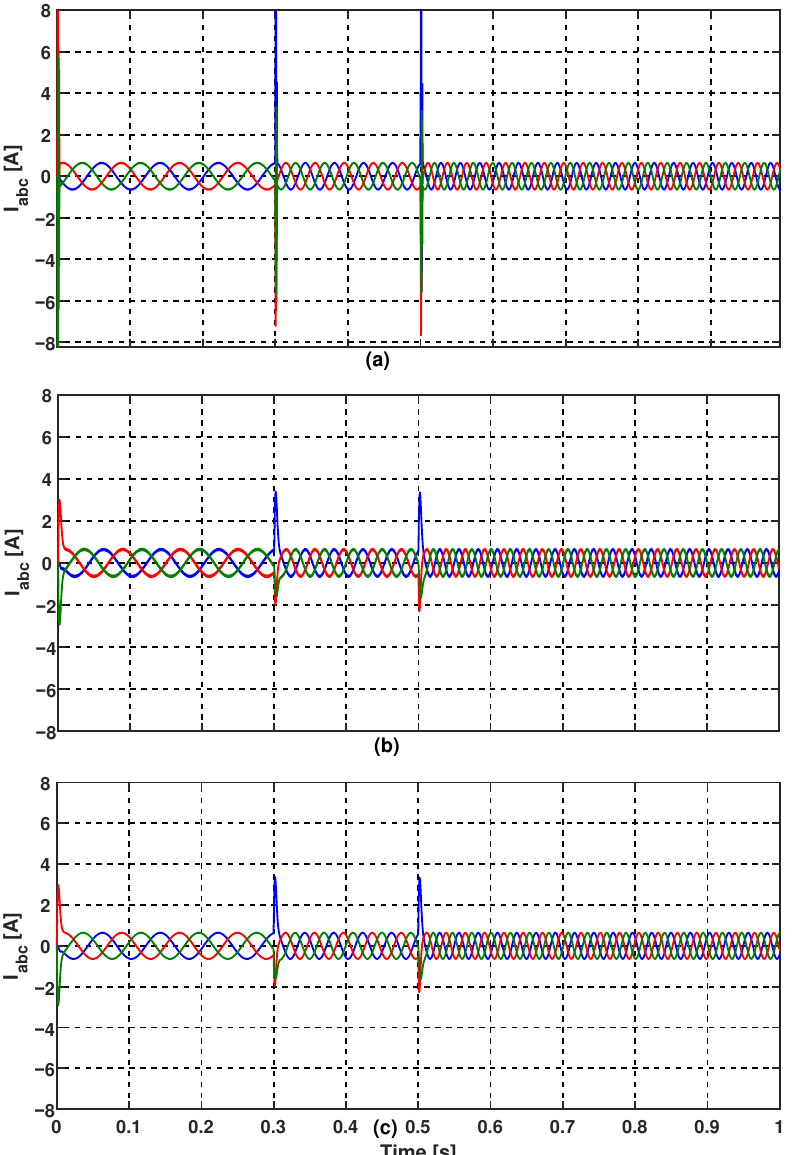
Figure 11. Three-phase currents of the PMSM in steady-state (from top): ( a ) Conventional FCS-MPC, ( b ) multiple-vector 2VV FCS-MPC, and ( c ) multiple-vector 3VV